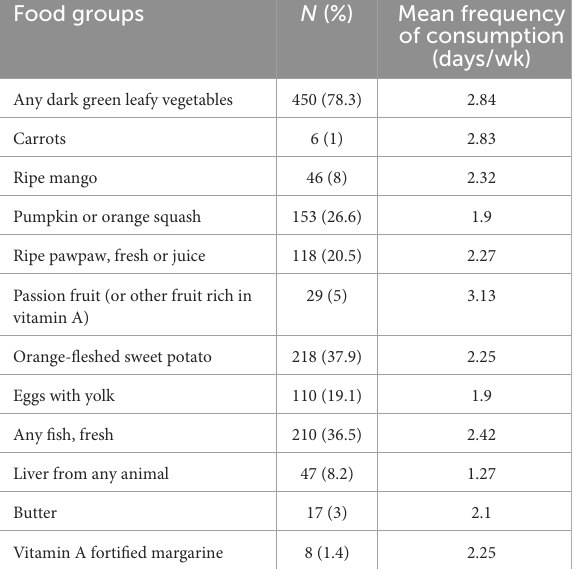
TABLE 7 Estimated correlation coefficient and unstandardized (b) coefficient for association between independent variables and vitamin A rich food consumption for